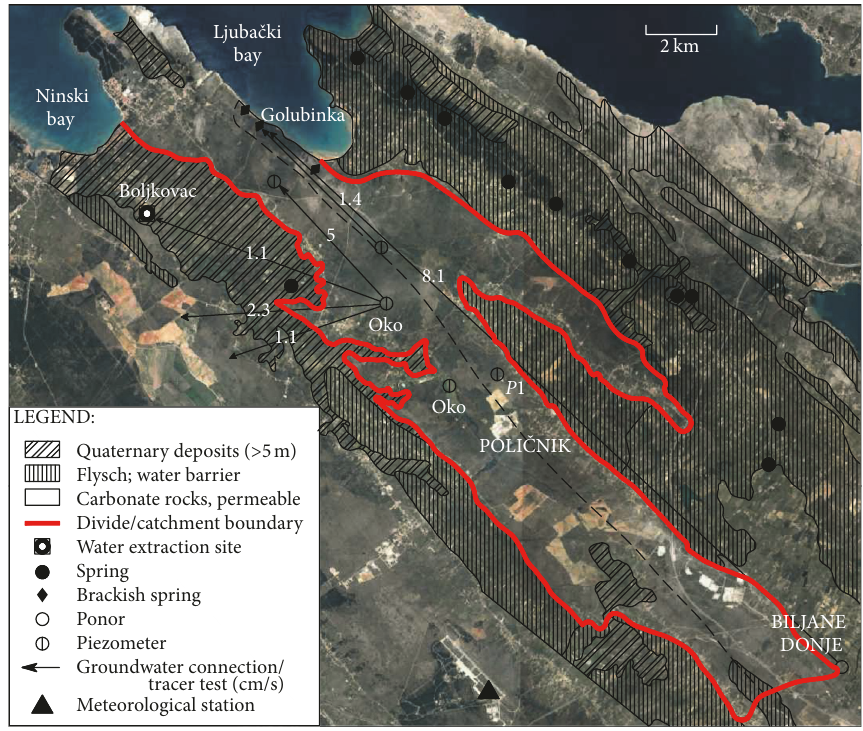
Figure 1: Schematic hydrogeological map of the Golubinka spring catchment